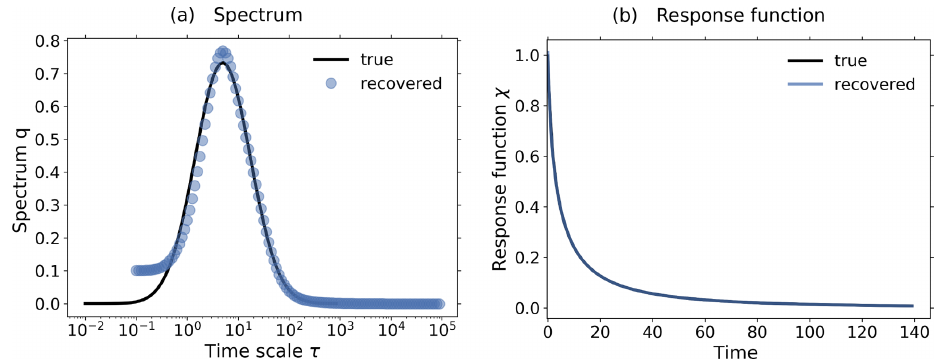
Figure E4. Response function χ(t) and spectrum q λ recovered from toy model data taking the RFI parameters M = 120, log τ min = − 1, and log τ max = 5. Blue dots in (a) and blue line in (b) indicate the recovered values for the spectrum and for the response function, while black lines indicate their “true” values.